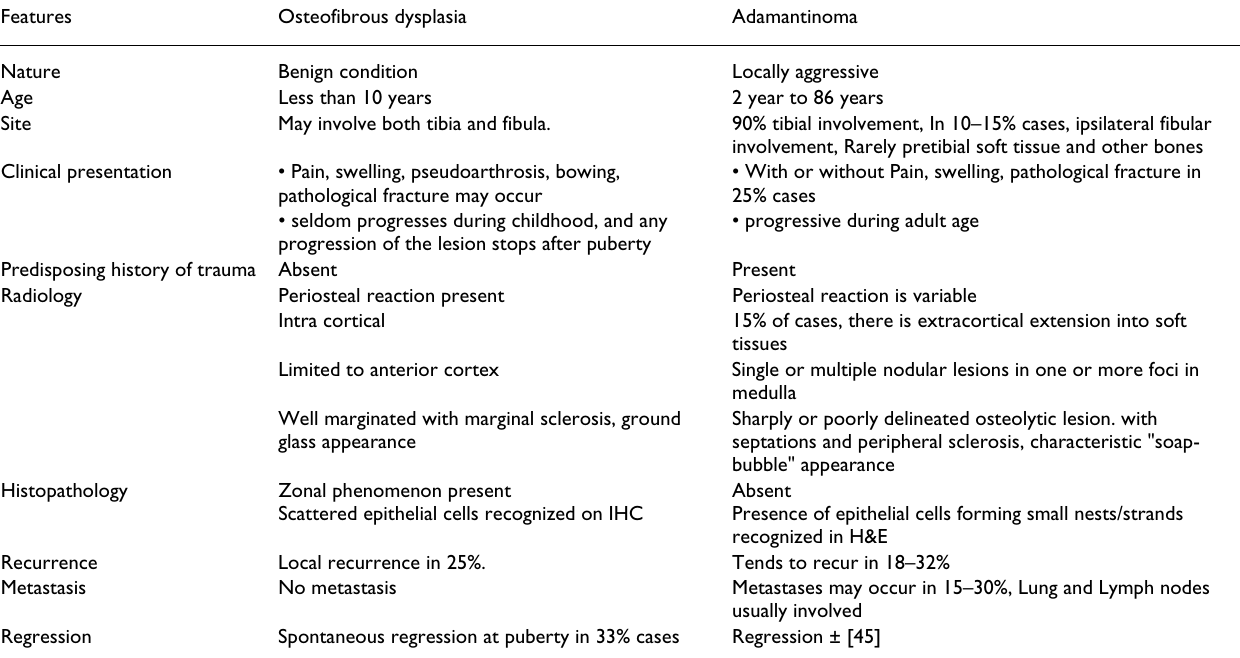
Table 3: Differences between Osteofibrous dysplasia and Adamantinoma